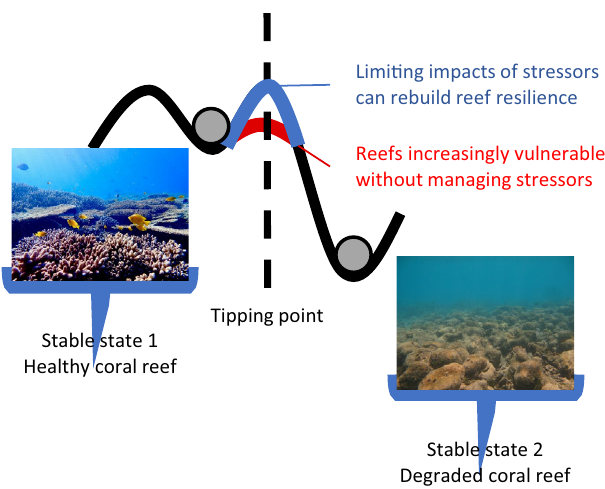
Fig. 3 The ‘ ball and cup ’ analogy of resilience, where greater resilience equates to a deeper cup, shows that building resilience (up the dashed line) in a system makes it less likely to be pushed past a tipping point into an irreversible change in state, deemed a ‘ regime shift ’ .